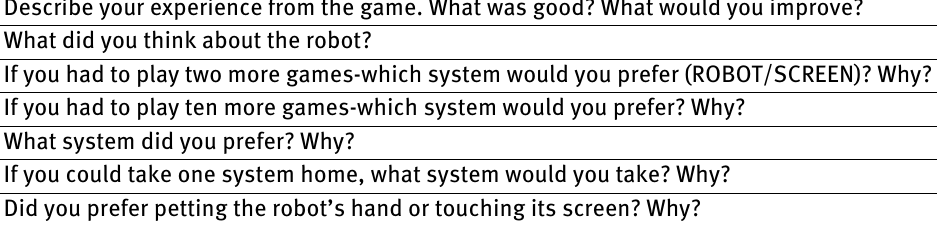
Table 2: The open-ended custom-built questionnaire of Experiment 2. Describe your experience from the game. What was good? What would you